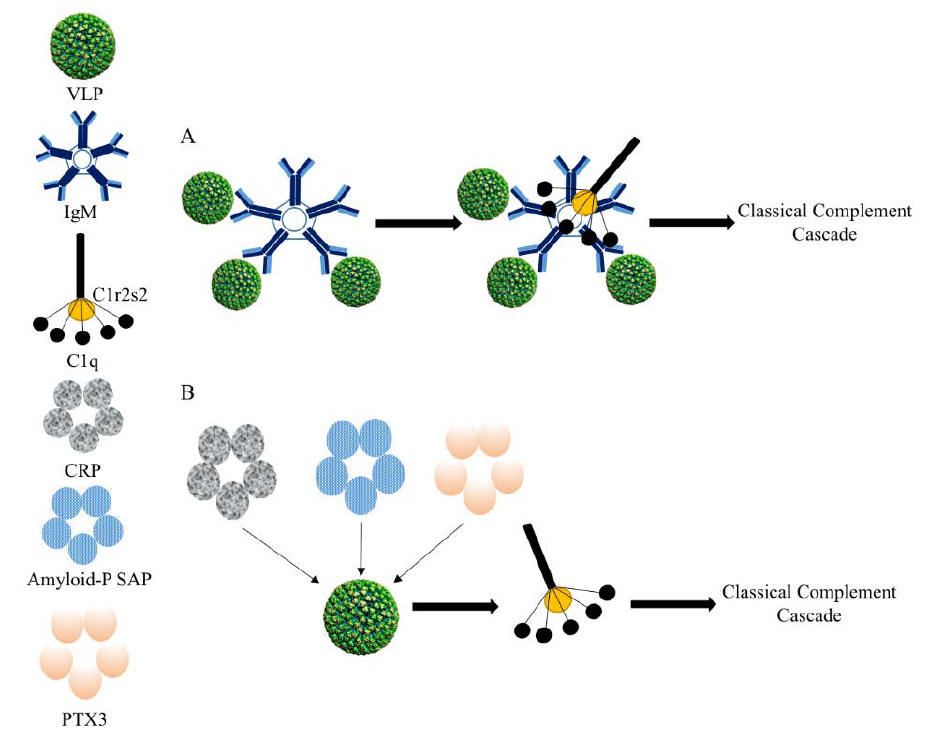
Figure 3. VLPs and innate humoral immune response. The repetitive surface of viral capsid-derived VLPs facilitates their interaction with molecules and components of the innate humoral immune system. ( A ) IgM binds the surface of VLPs via low affinity/high avidity interaction. This binding activates C1q molecules resulting in the initiation of the classical complement cascade. ( B ) More speculative, pentraxin protein family members including CRP, amyloid P SAP and PTX3 may also recognize and bind the repetitive surface structure of VLPs resulting in the activation of C1q molecule and the initiation of the classical complement cascade.